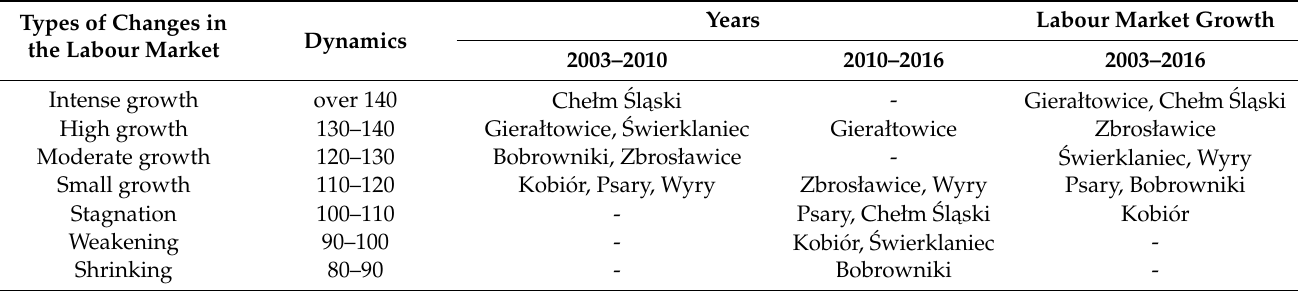
Table 3. Types of changes in rural labour markets in the hinterland of the GZM in 2003–2016. Types of Changes in